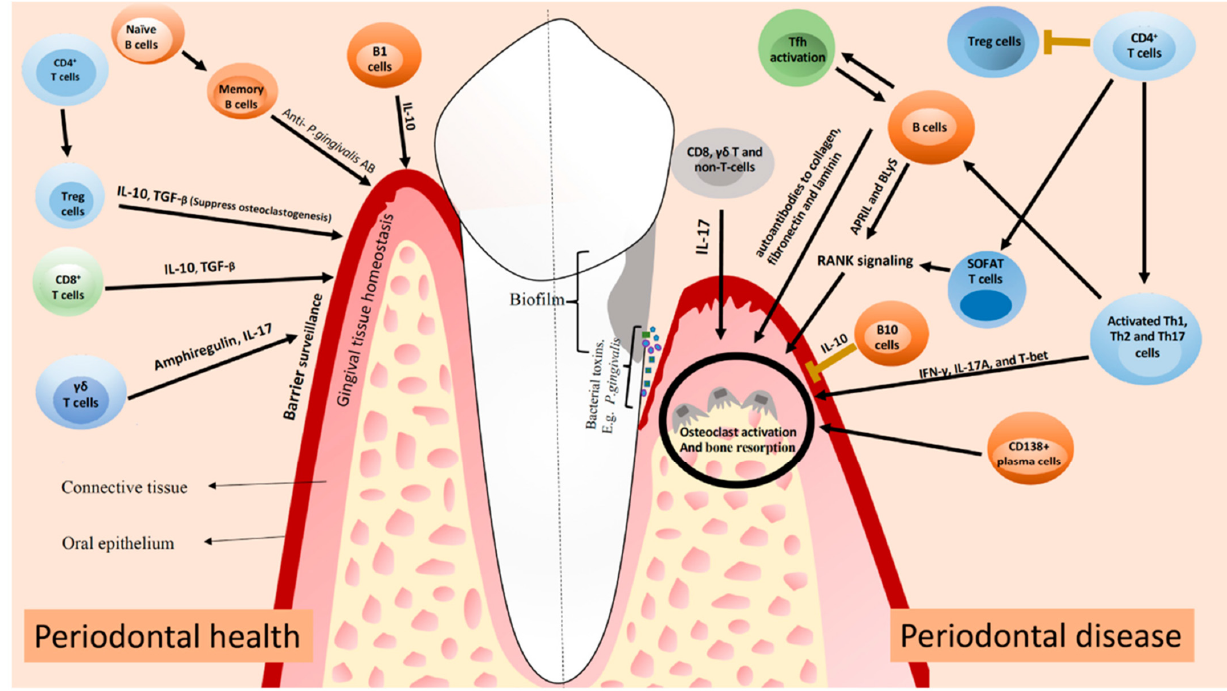
Figure 2. A synopsis of how the previously described T and B cells can contribute to periodontal health and disease. Treg and cytotoxic T cells (CD8+ T cells) in periodontal health contribute to periodontal homeostasis by producing IL ‐ 10 and transforming growth factor ‐ ß (TGF ‐ ß). To improve periodontal homeostasis, (cid:2237)(cid:2238) T cells generate amphiregulin and IL ‐ 17. B cells generate antibodies against periodontal bacteria, slowing the progression of periodontal inflammation. Activated TH1, TH2, and TH17 cells in periodontal disease release pro ‐ inflammatory cytokines that lead to tissue destruction. T and B cells both generate receptor activator of nuclear factor (cid:2244) B ‐ Ligand